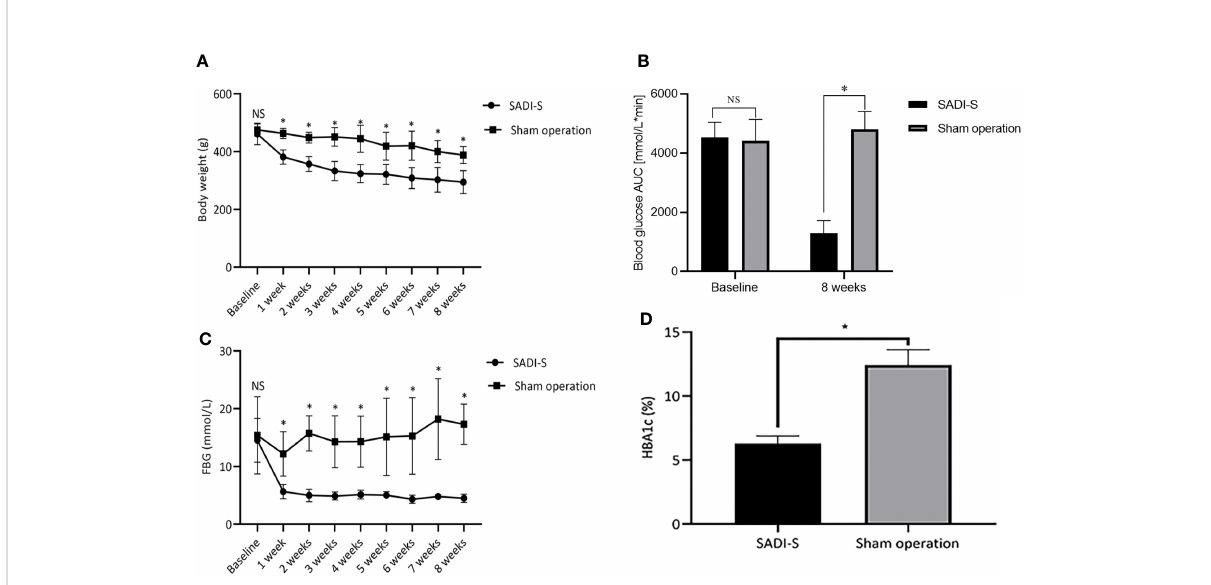
FIGURE 1 Changes in body weight (A) , changes in blood glucose AUC during IPGTT before and after surgery (B) and FBG (C) before and after surgery. Comparison of the HBA1c level at 8 weeks after surgery between the two groups (D) . All values are expressed as Mean ± SD. NS indicates no signi fi cant difference between the SADI-S group and sham operation group. * represents a signi fi cant difference between the SADI-S group and sham operation group (P<